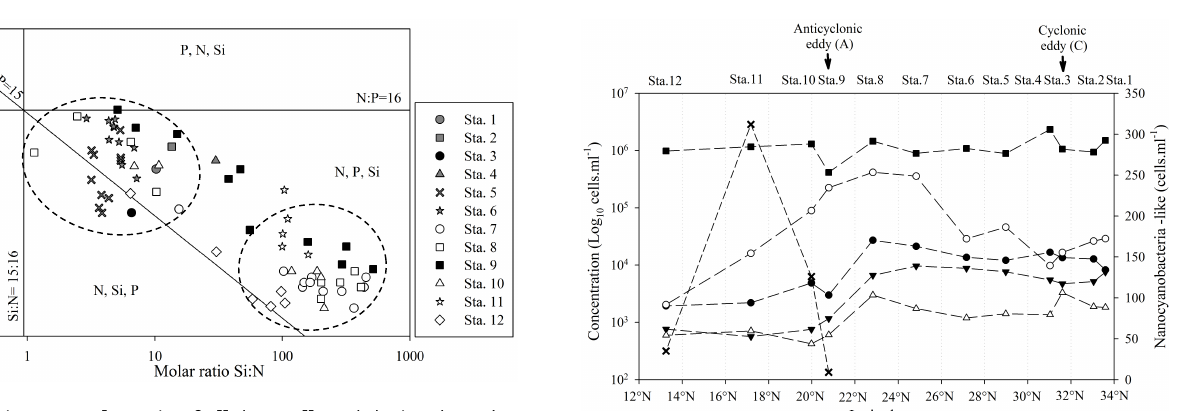
Fig. 7. Si:N:P molar ratio of all data collected during the Tokyo Palau cruise. In each area, delimited by the Brzezinski (1985) Si:N:P=15:16:1, the potential limiting nutrient are shown in or- der of priority. The black symbols show the sampling depth near the cyclonic and anticyclonic gyres (stations 3 and 9, respectively). The black dotted circles discriminated two groups of sampling points depending on their nutrient ratios.